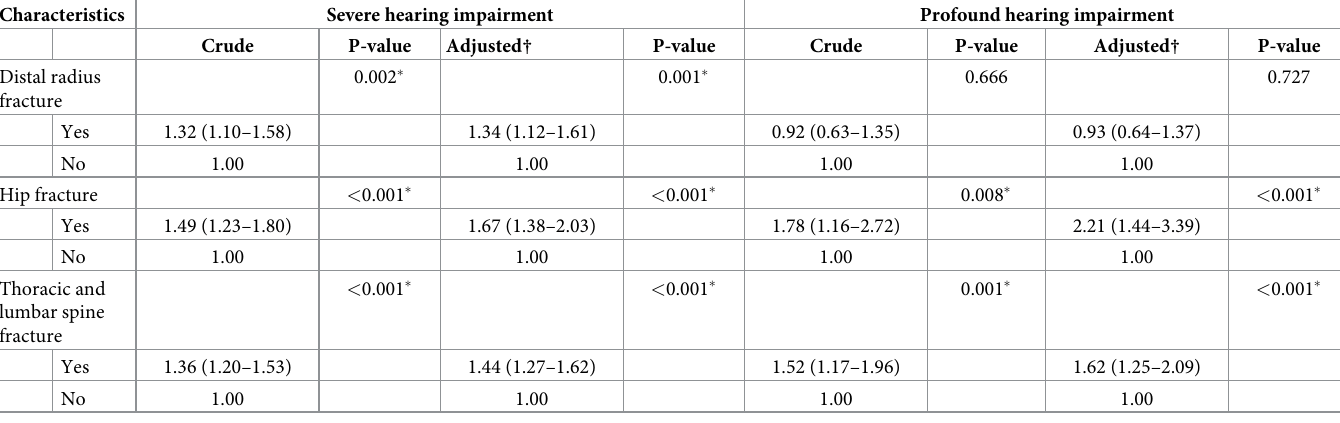
Table 2. Crude and adjusted hazard ratios (95% confidence interval) of hearing impairment for distal radius/hip/thoracic and lumbar fracture.